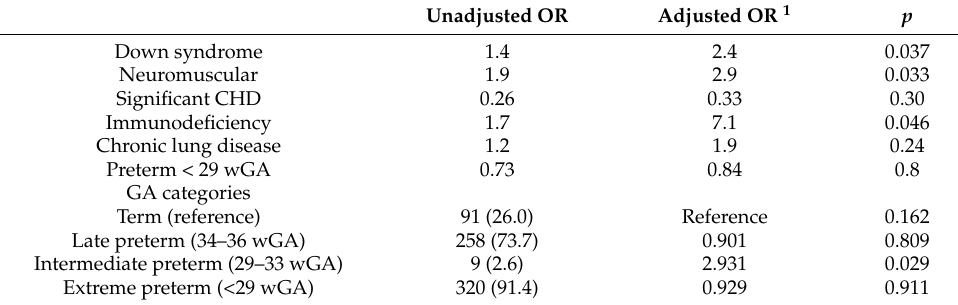
Table 4. Risk factors predicting PICU admission.